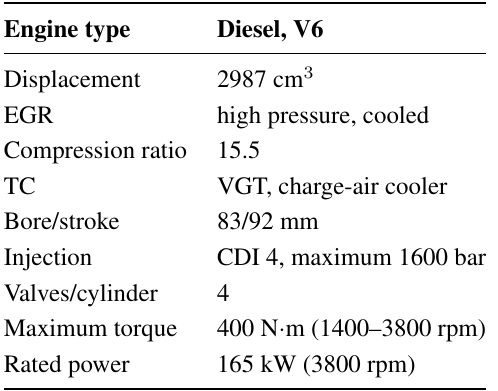
Table 1. Main data of the engine used in this work. EGR: exhaust gas recirculation; VGT: variable geometry turbine; TC: turbocharger; and CDI: common-rail diesel